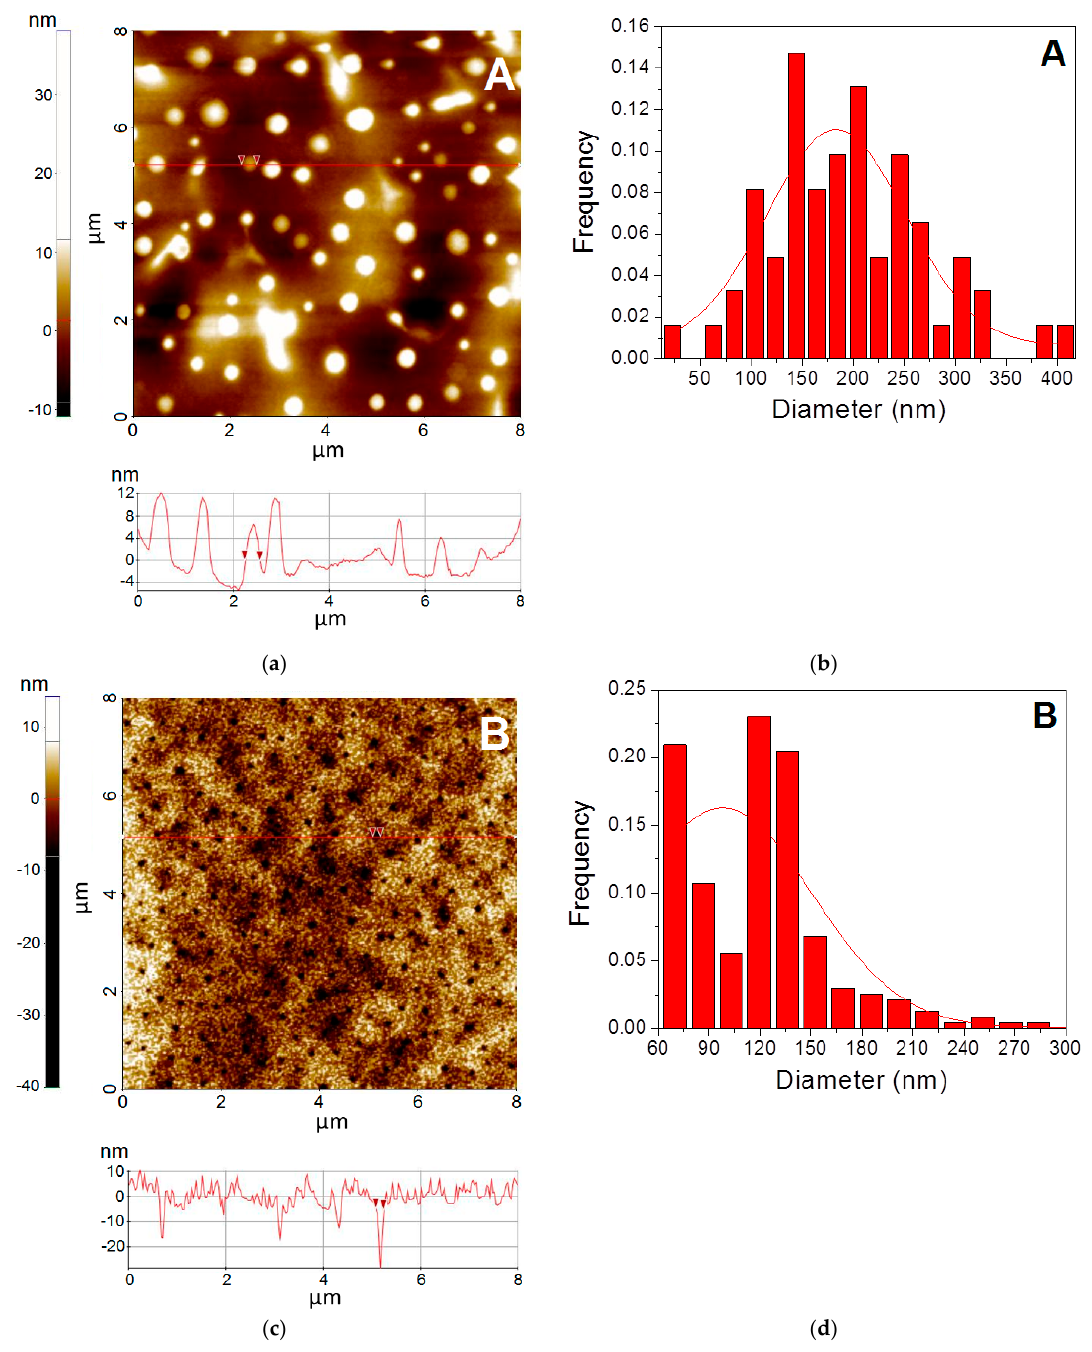
Figure 4. ( a ) 2D AFM images of the hybrid films formed by deposition of silica material. ( b ) Diameter histograms of the superficial protruding clusters formed on the surface of silica film and of silver-based silica material. ( c ) 2D AFM images of the hybrid films on glass substrates, registered at the scale of 8 μ m× 8 μ m, accompanied by representative line-scans. ( d ) Diameter histograms of the superficial protruding clusters and on the surface of silver-based silica film.